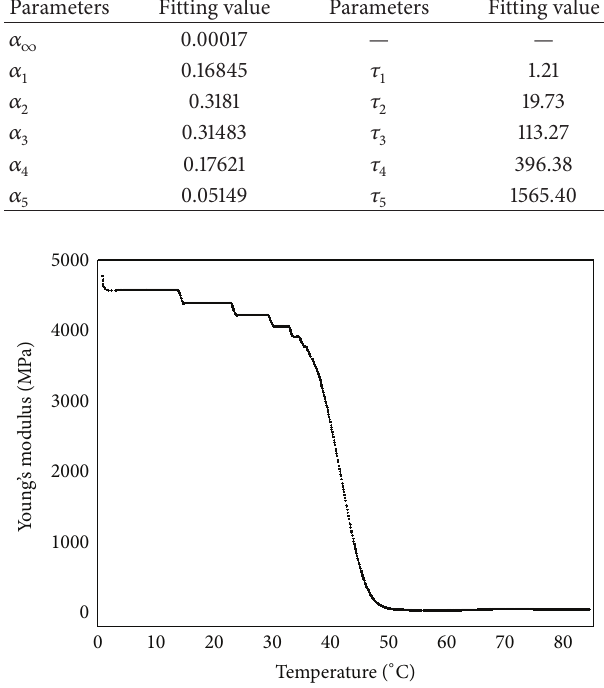
Figure 5: Elastic modulus-temperature curve of PLGA.